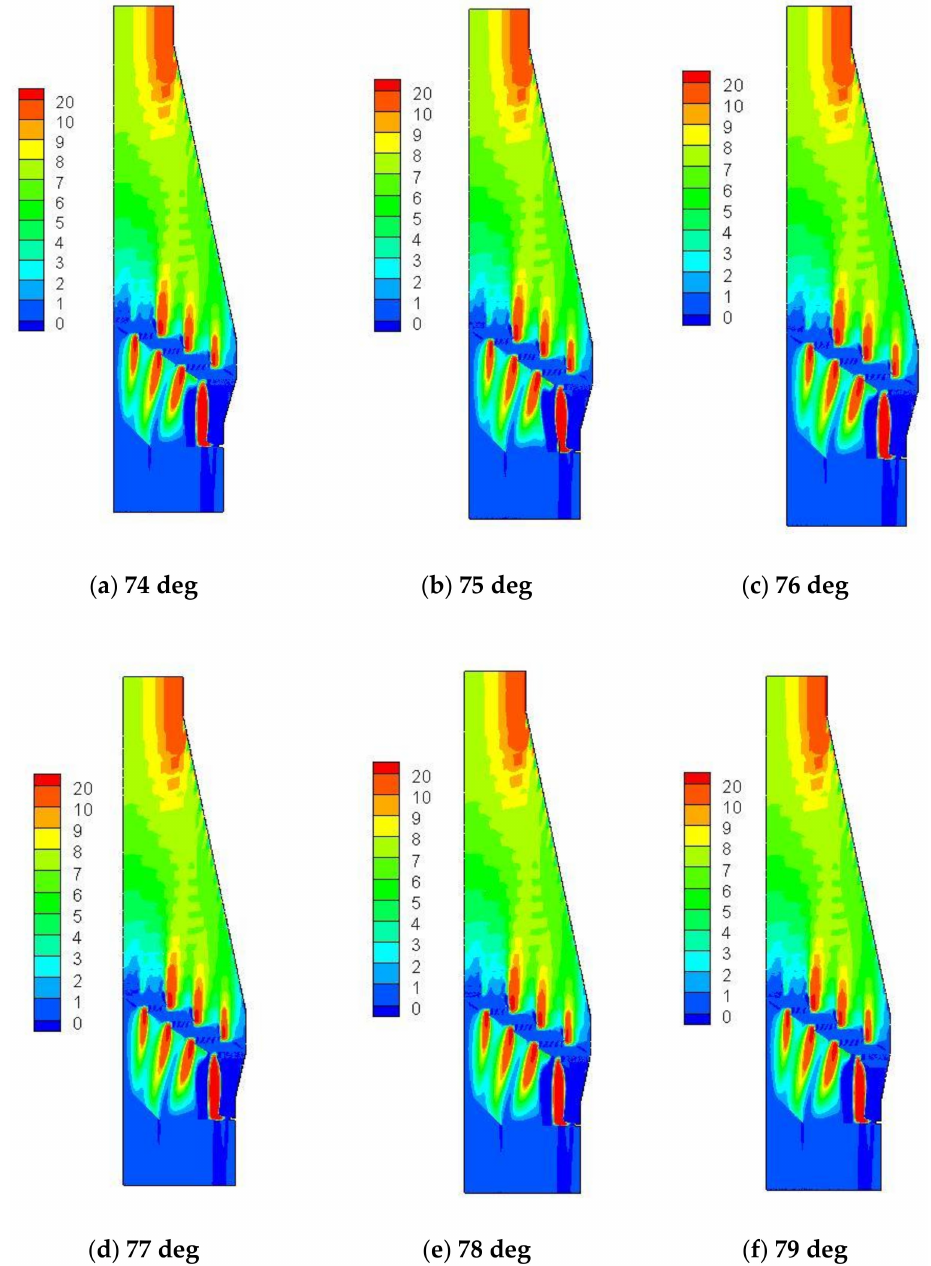
Figure 10. Radial distribution of the airflow velocity (m/s) under different bosh